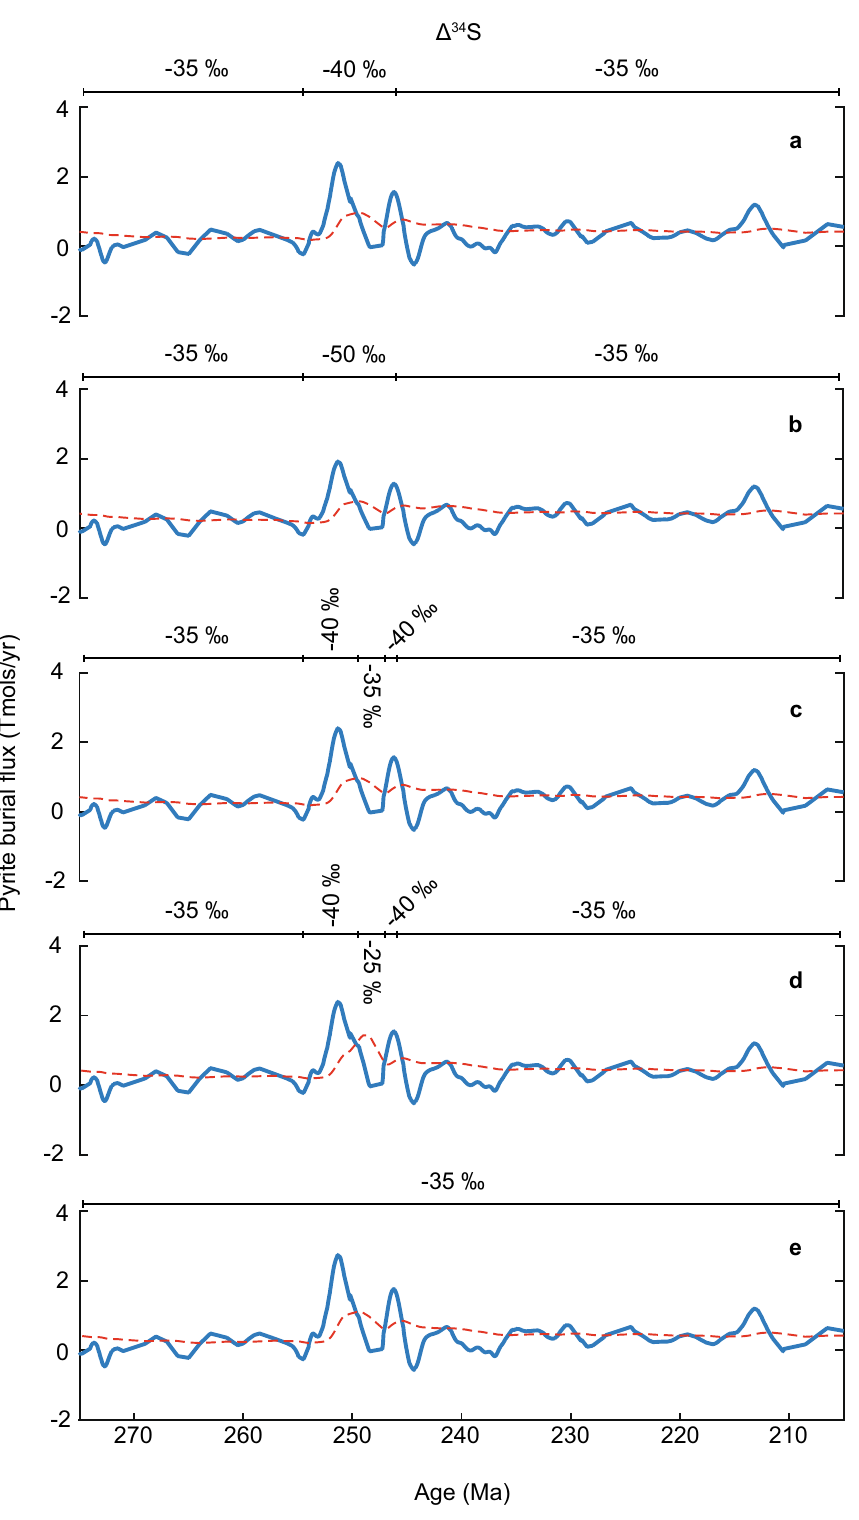
Figure 3. Sensitivity of the modelled pyrite burial flux to changes in the fractionation factor for the chemical reduction of sulphate to sulphide (Δ 34 S), and subsequent pyrite formation. The bar above each model output displays the value set for Δ 34 S at different intervals of time. The only parameter changed between each model run is Δ 34 S, enabling us to test the influence of this specific paramer on the inferred pyrite burial